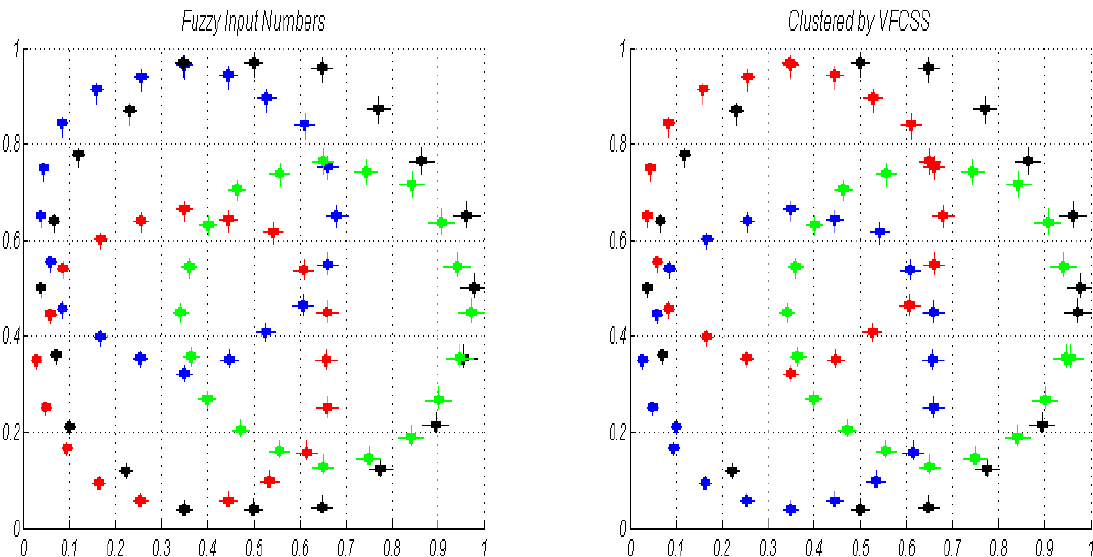
Figure 3. Proposed VFCSS clustering over input LR-type fuzzy numbers include four complexity interference classes red, blue, black and green with (20,20,20,20) members, (second step of state 1).